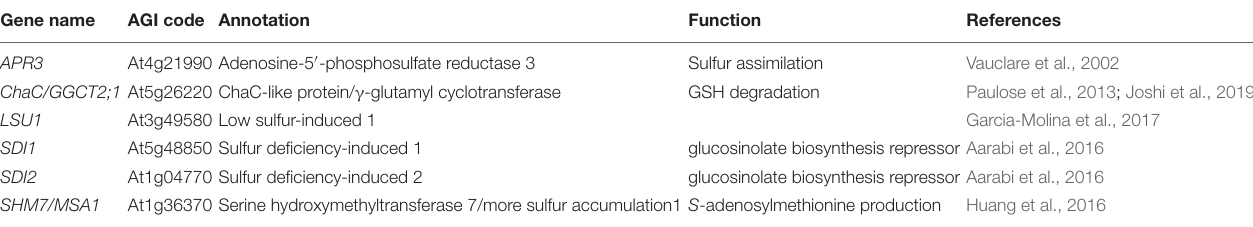
TABLE 2 | OAS cluster genes in Arabidopsis